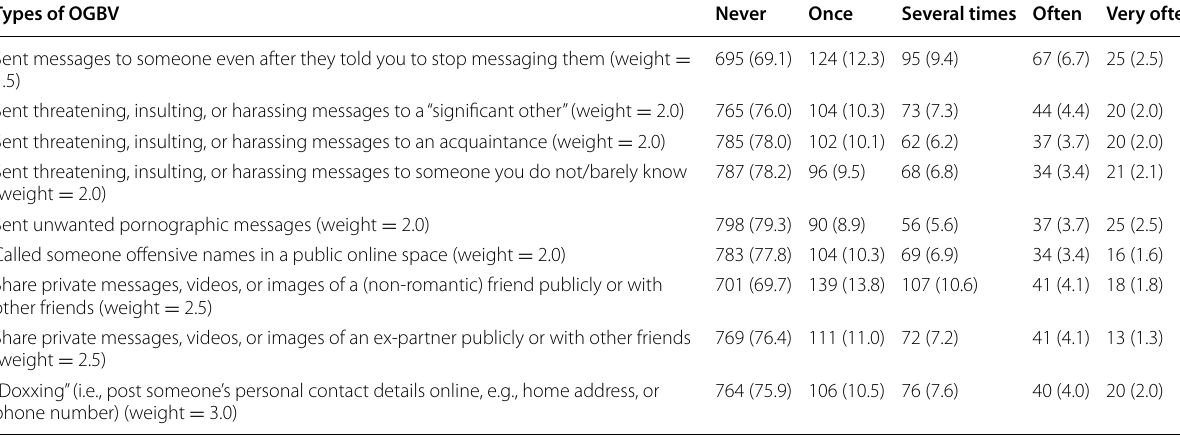
Table 2 Types and frequency of online gender-based violence perpetrated by respondents Types of